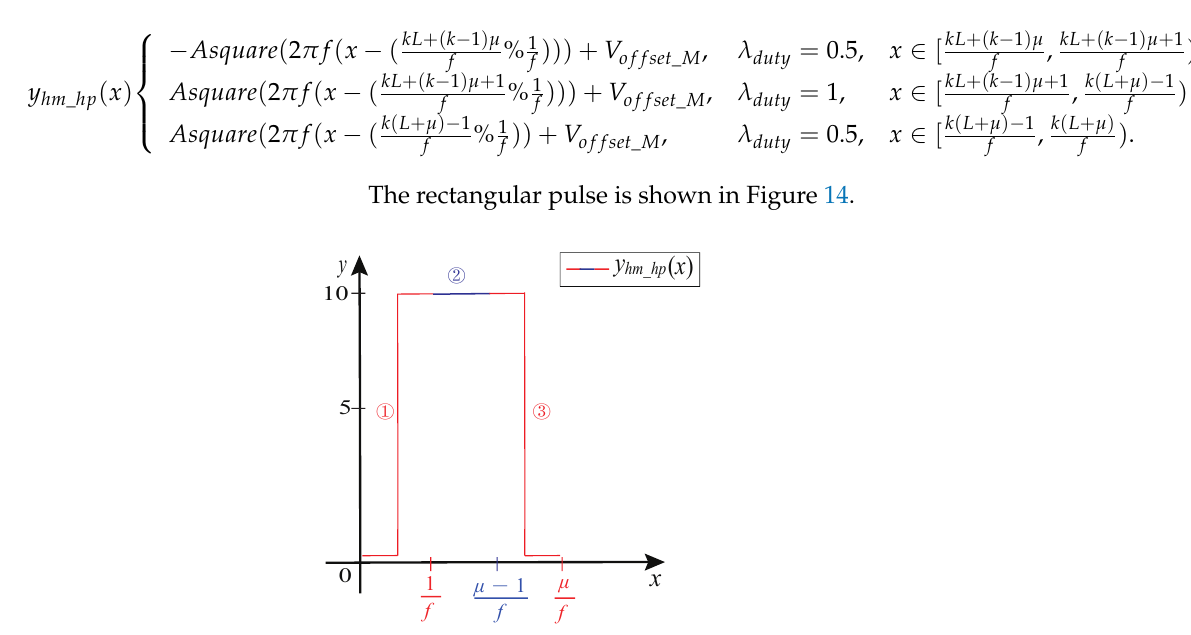
Figure 14. The rectangular pulse. Stage 2: Horizontal line Modeling. The voltage amplitude of the horizontal line is 0. The length of the horizontal line and the marked pulse signal’s position parameters are the same as that of the magnetoelectric CMP signal. The horizontal line waveform is generated according to Equation (24).